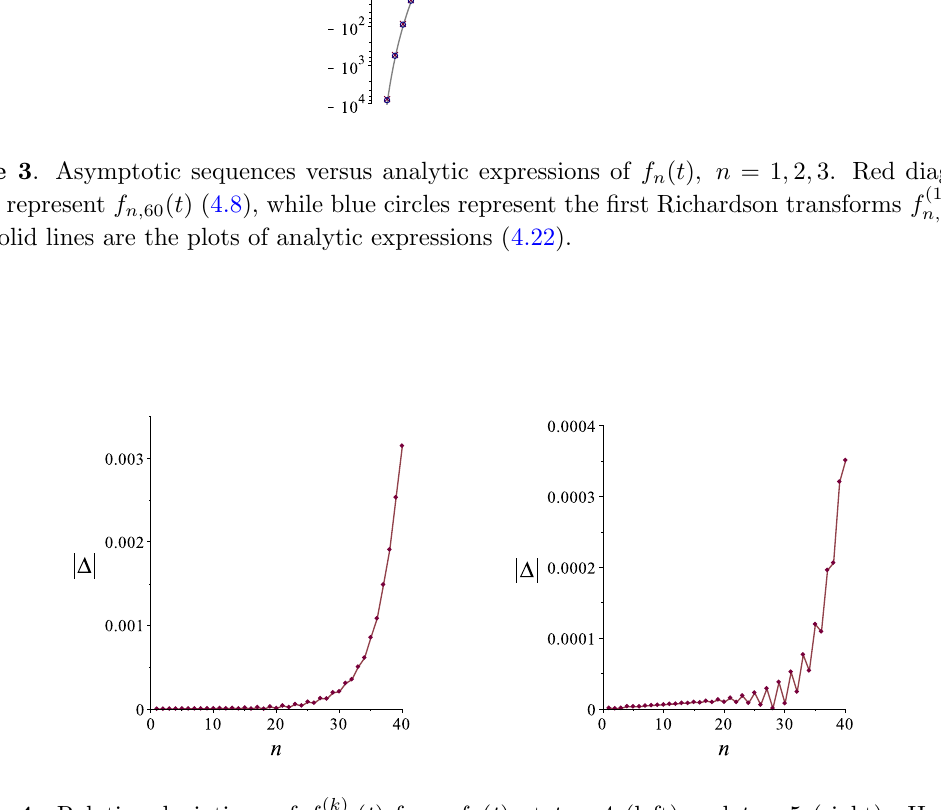
Figure 4 . Relative deviations of f ( k ) n;m ( t ) from f n ( t ) at t = 4 (left) and t = 5 (right). Here we consider the second Richardson transforms k = 2 ; m = 58 in (4.24).